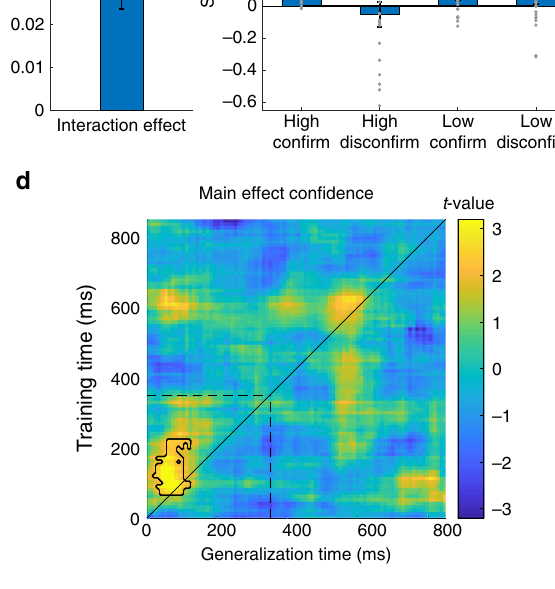
Fig. 4 MEG analysis investigating the in fl uence of con fi dence on post- decision evidence processing (MEG study 3, n = 25 participants). a , b Neural metrics of post-decision accumulation separated into con fi rming (consistent with initial decision) and discon fi rming (inconsistent with initial decision) post-decision evidence and as a function of high ( a ) and low ( b ) initial con fi dence. More positive values on the y-axis indicate stronger (more veridical) representation of the presented motion. Weighted group averages (grand average) are presented and regression lines are fi ts to this averaged data. c Effects of initial decision and con fi dence on the slope of neural evidence accumulation in response to post-decision evidence (slope). The righthand panel shows weighted mean values± SEM for the strength of neural evidence integration (slope) within each condition. Grey dots represent individual participants ’ data. The lefthand bar shows the fi xed effect ± SEM for the initial decision × con fi dence interaction effect from a hierarchical regression (two-tailed): ** p = 0.008. d Effect of con fi dence on temporal generalization of decoding accuracy from the pre- to the post-decision phase. Higher con fi dence is associated with higher decodability of the initial decision (i.e. stronger representation of the initial decision, yellow colours). A stronger representation of the initial decision was seen at the beginning of the post-decision period when con fi dence was high, consistent with con fi dence shifting a starting point towards the bound of the initial decision. The contoured area represents a cluster of timepoints with a signi fi cant main effect of con fi dence (permutation test, p < 0.05 corrected for multiple comparisons). The time window starts with stimulus presentation (0 ms) and ends when the response options are presented (850 ms). Dotted lines indicate the offset of the stimulus (pre- or post- decision stimulus